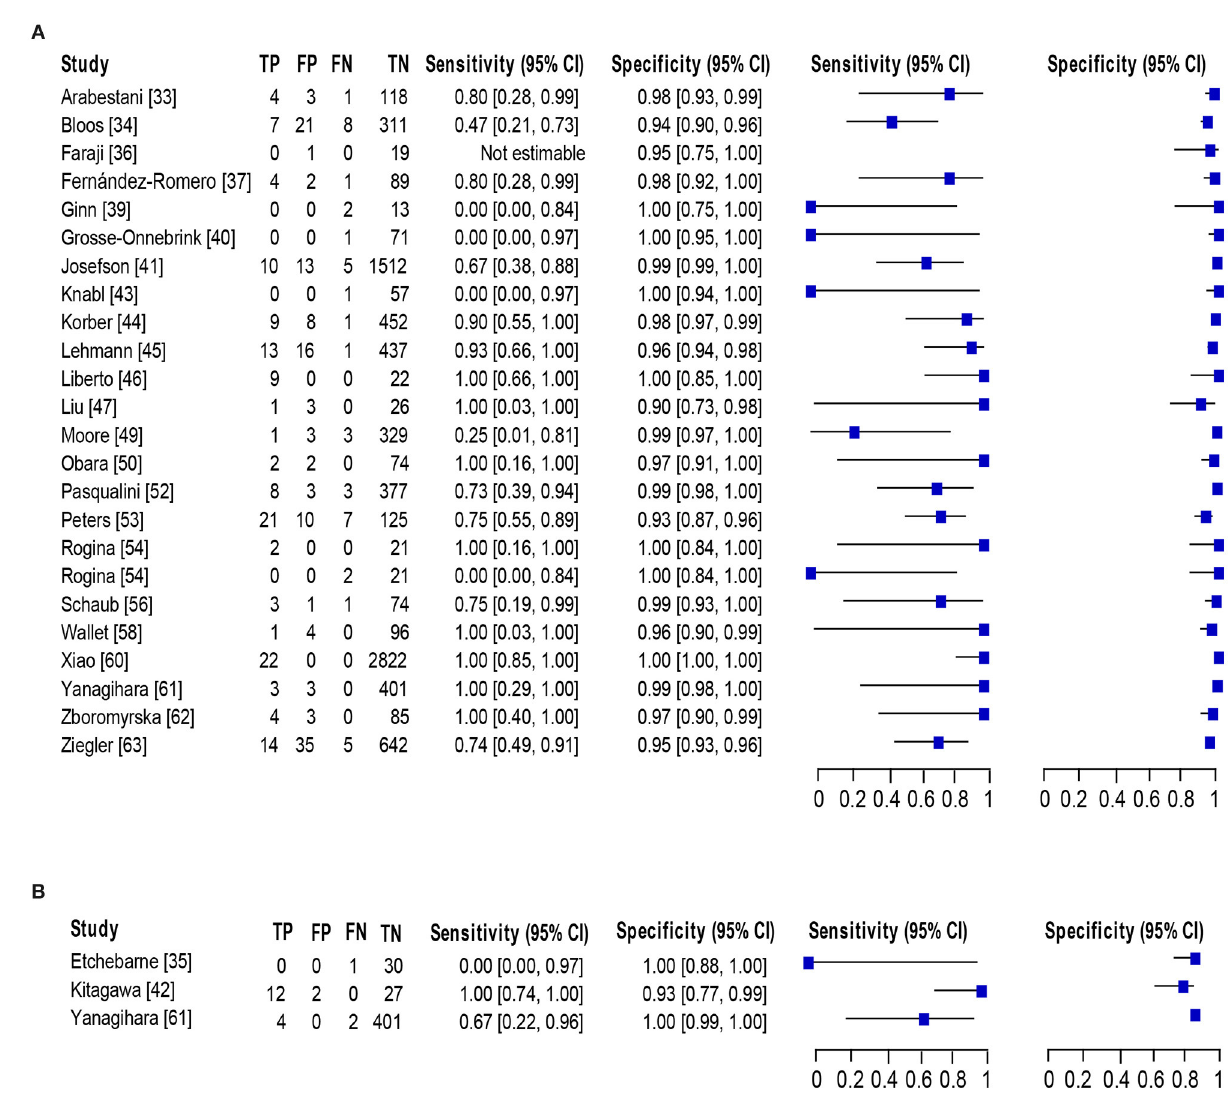
( Figure 4B ). Pooled summary estimates of NAAT for MSSA identification was lower [sensitivity: 0.76 (95% CI 0.69–0.82), specificity: 0.98 (95% CI 0.98–0.99), PLR: 28.63 (95% CI